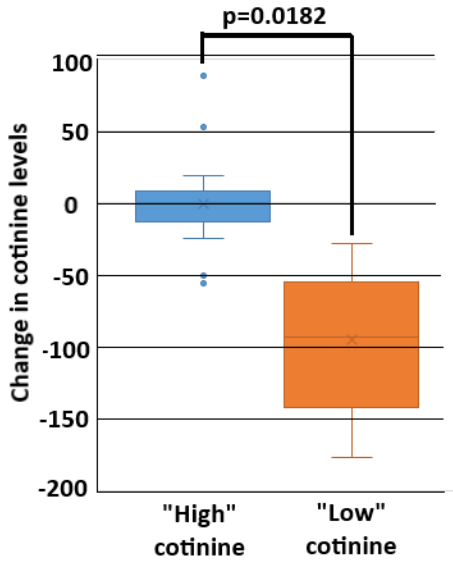
Figure 2. Mean change in pediatric cotinine levels at the time of caregiver fulfillment of “low” cotinine status, compared to the final month in those assigned to the “high” cotinine status.